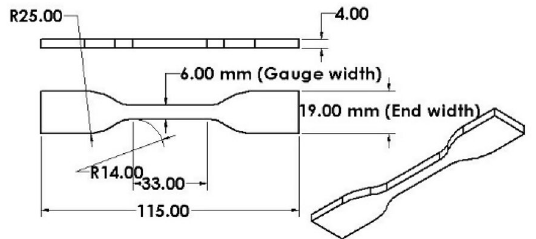
Figure 1 Tensile specimen dimensions (mm)